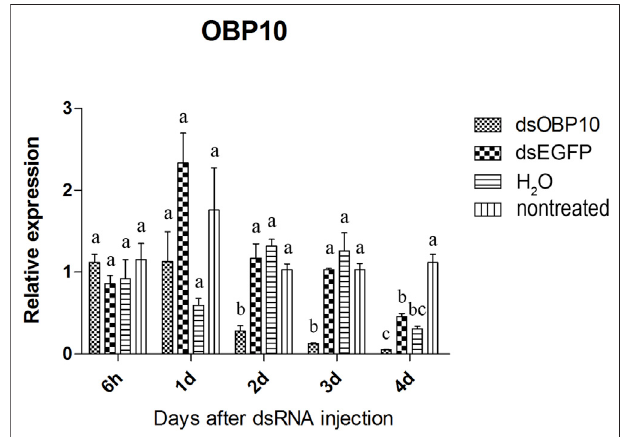
FIGURE 1 | Relative expression of OBP10 in EAB adults after dsRNA injection. Relative expression of OBP10 by RT-qPCR assay was evaluated 6 hours, 1, 2, 3 and 4 days after injecting 3 µg dsRNA. TEF-1 α was used as a reference gene for normalization. Means ± SE (n = 4) are shown. StatisticalanalyseswereperformedusingANOVA/LSDmethodat p < 0.05for comparison among treatments. Statistical differences are shown by different letters between different treatments at the same time